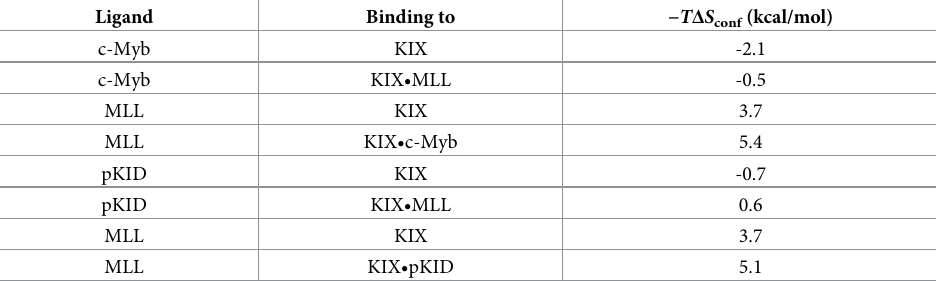
Table 1. KIX conformational entropy changes in wild type systems that occur with activator binding at 298 K cal- culated using methyl order parameters from